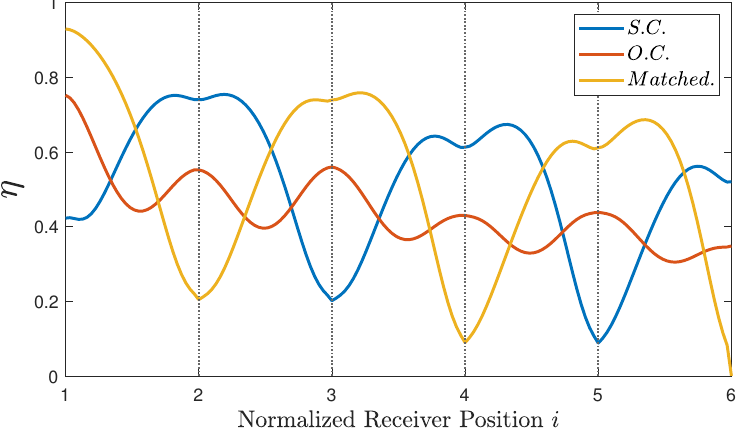
Figure 13. Transmission efficiency in the cases of S.C., O.C. and matched terminations for R l = 5 Ω